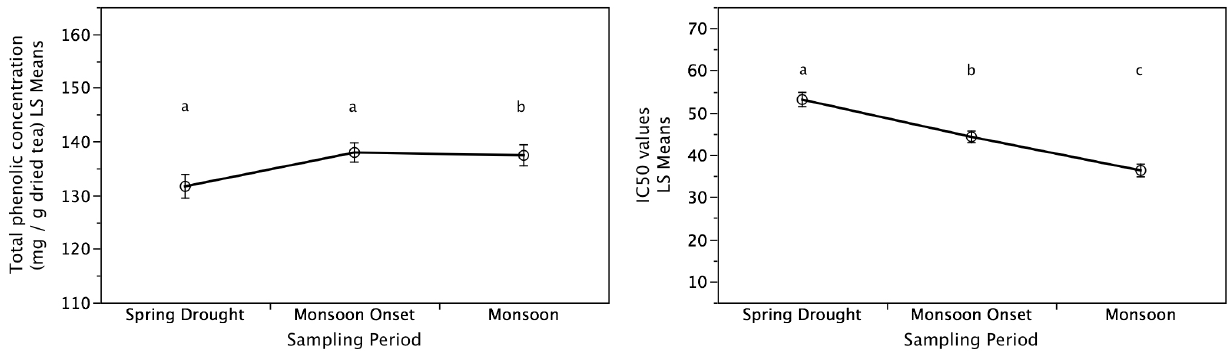
Figure 5. Effects of Precipitation Variability on Total Phenolic Concentration and Antioxidant Activity. Increased precipitation from the spring drought to the monsoon tea harvest resulted in significantly higher total phenolic concentration (TMC) and antioxidant activity of tea leaves. Sampling periods not connected by the same letters are significantly different. Values are means 6 one standard error.